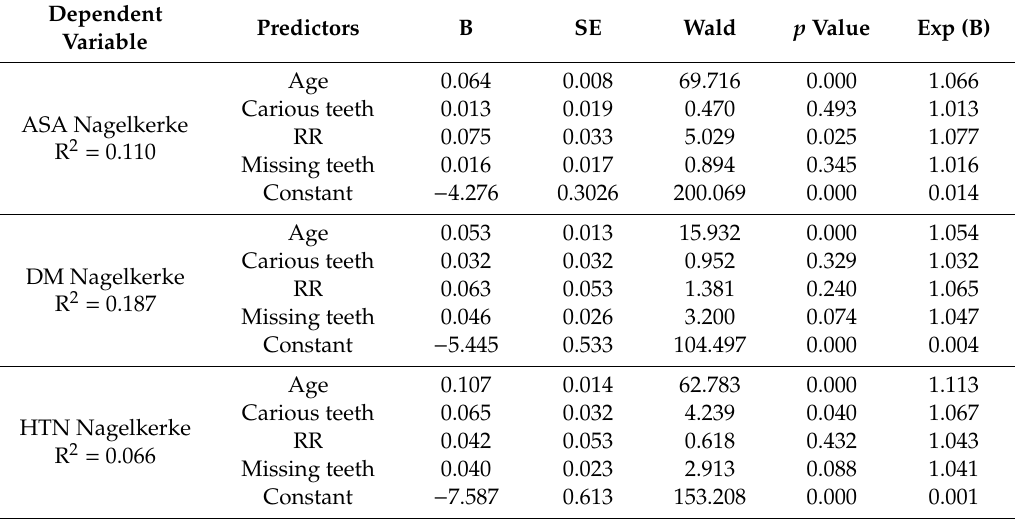
Age 0.107 0.014 R 2 = 0.066 Constant